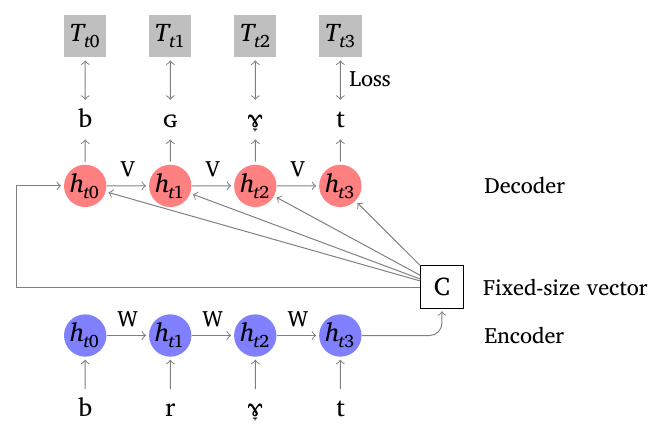
Figure 3: Structure of our RNN encoder-decoder